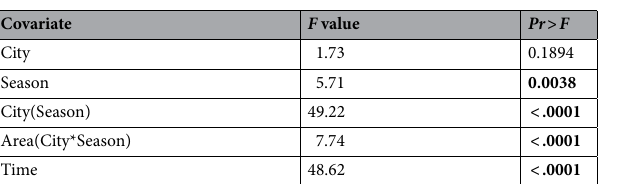
Table 2. Results of the GLIMMIXED regression with a generalized Poisson estimator and log link to assess the effect of geographic location, seasonality, and time in the diel activity of Ae. aegypti . Bold values indicate statistically significantly